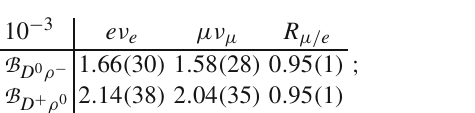
Table 1 Upper panel–A. SCI predictions for almost all electroweak transition form factors can reliably be interpolated using Eq.(8) and the coefficients in columns 1-12. For A 1 ( t ) in B 0 → ρ − , B s → K ∗− , an accurate interpolation requires Eq.(14) instead, with c = 0 . 64 , 0 . 77, respectively. Column 13 lists r 2 = A 2 ( 0 )/ A 1 ( 0 ) and column 14, r V = V ( 0 )/ A 1 ( 0 ) . Lower panel–B. SCI computed branching fractions for